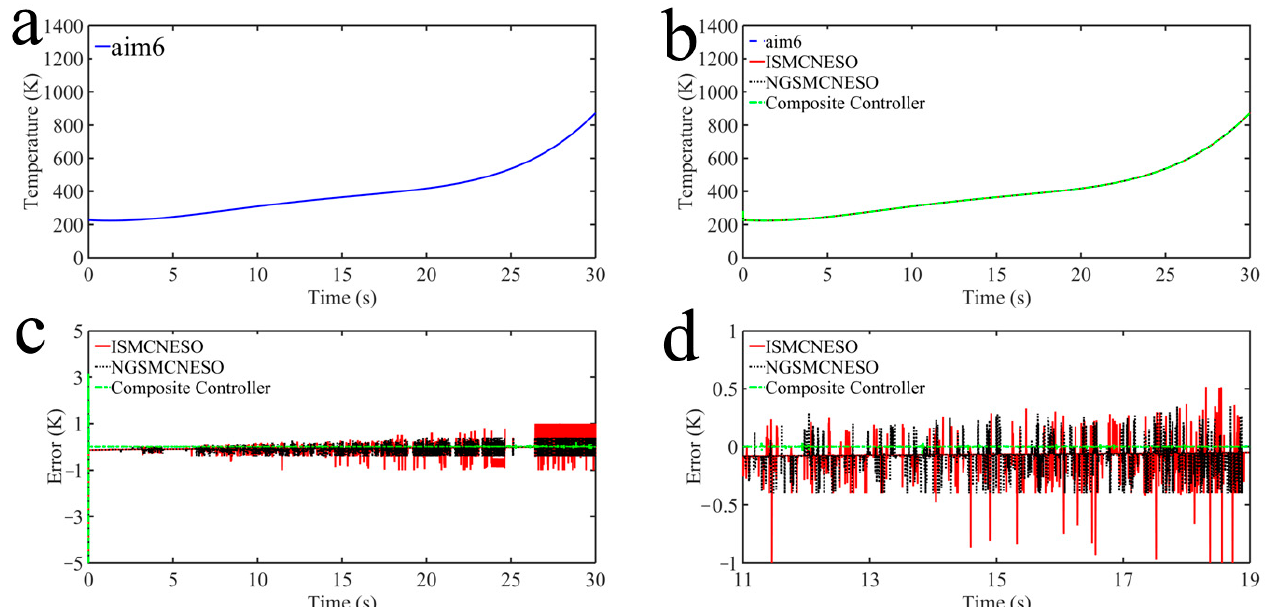
Figure 19. Simulation results: ( a ) the fitting curve of the reference temperature trajectory from Wall 1_85 mm; ( b ) the reference temperature tracking performance among ISMCNESO controller, NGSMCNESO controller, composite controller; ( c ) the tracking errors; ( d ) their partial enlarged figures in details.